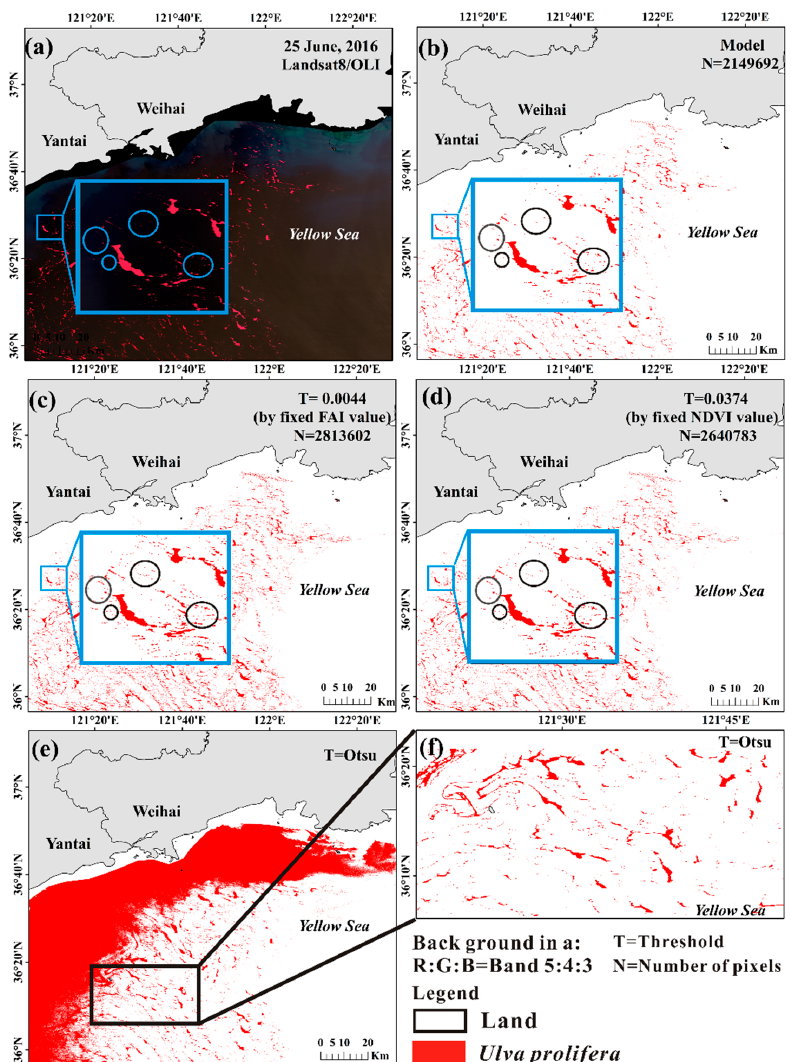
Figure 17. Comparison of adaptive threshold model with other methods. The blue box is the zoom of the same area in ( a – d ). ( a ) Landsat8/OLI pseudo-true-color image on 25 June 2016, R:G:B = band 5:4:3, ( b ) distribution map of U. prolifera based on the model in this paper, ( c ) distribution map of U. prolifera based on a fixed FAI threshold of 0.0044, ( d ) distribution map of U. prolifera based on a fixed NDVI threshold of 0.0374, ( e ) distribution map of U. prolifera based on the Otsu method, ( f ) distribution map of U. prolifera based on the Otsu method from the black box area in ( e ).